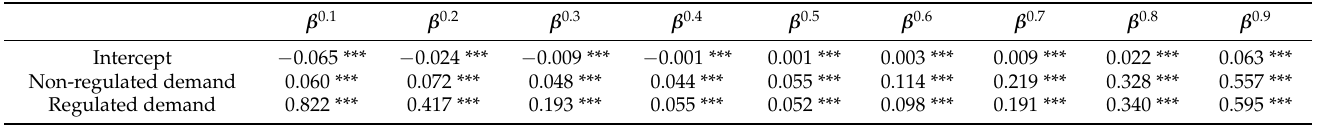
Table A3. Quantile regression coefficients for the different quantiles in 2020.